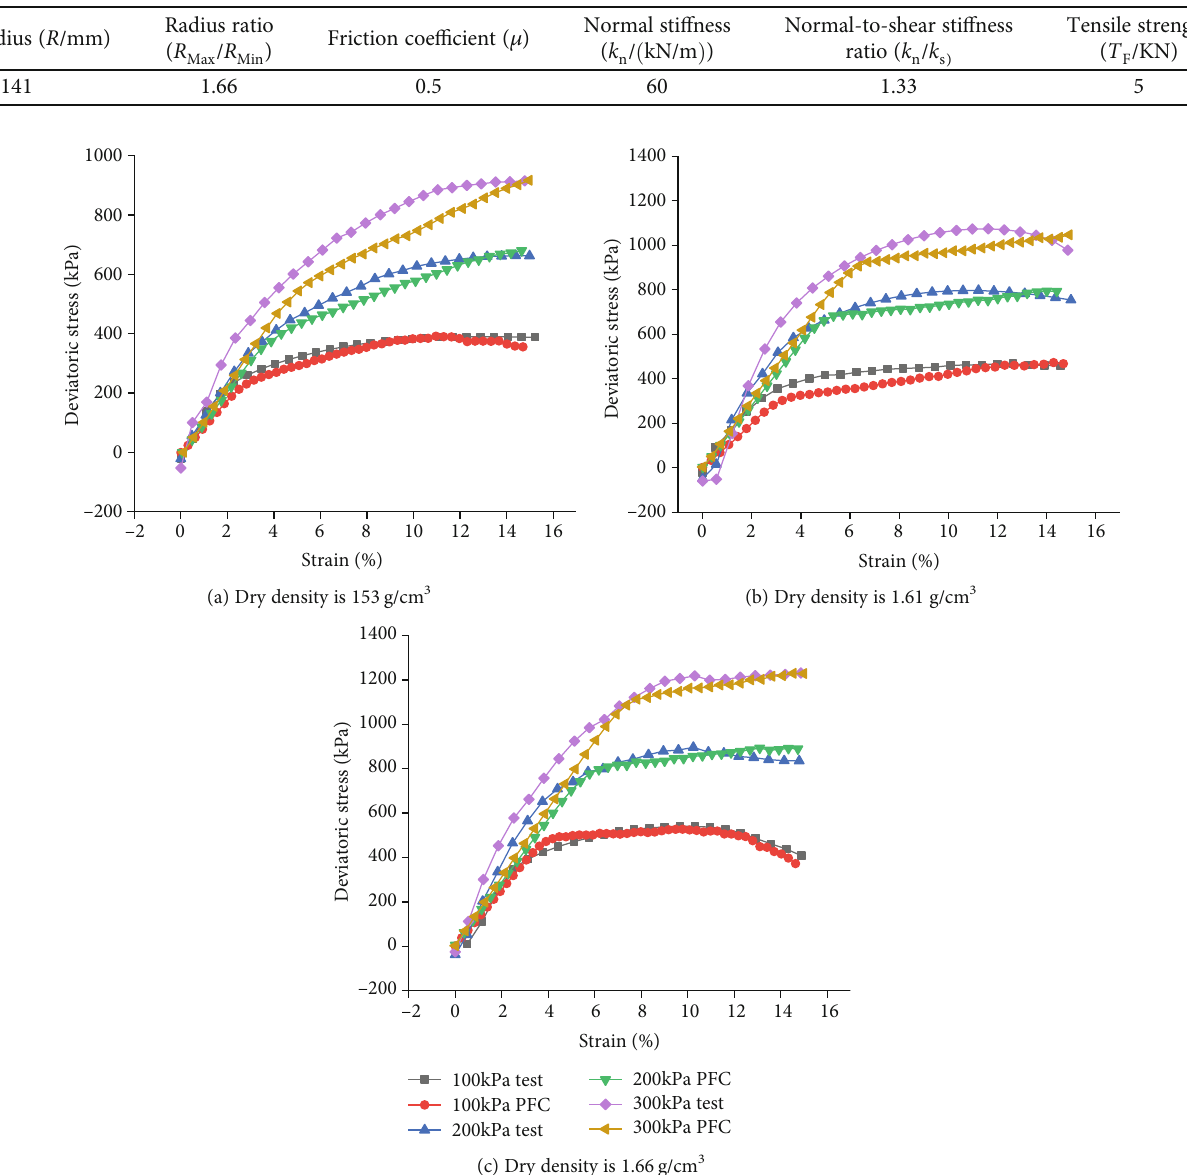
Table 2: Particle fl ow simulation parameters.